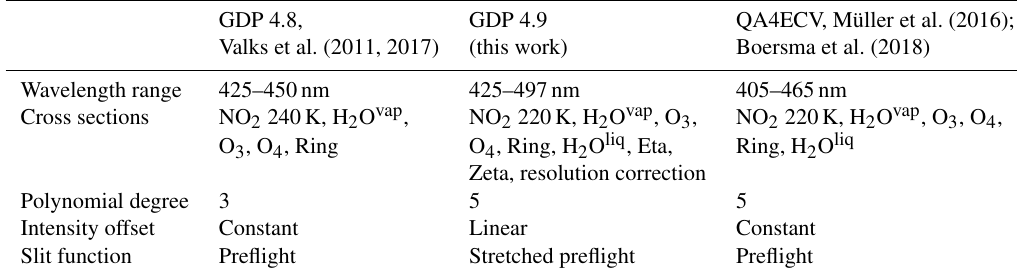
Table 1. Main settings of GOME-2 DOAS retrieval of NO 2 slant columns discussed in this